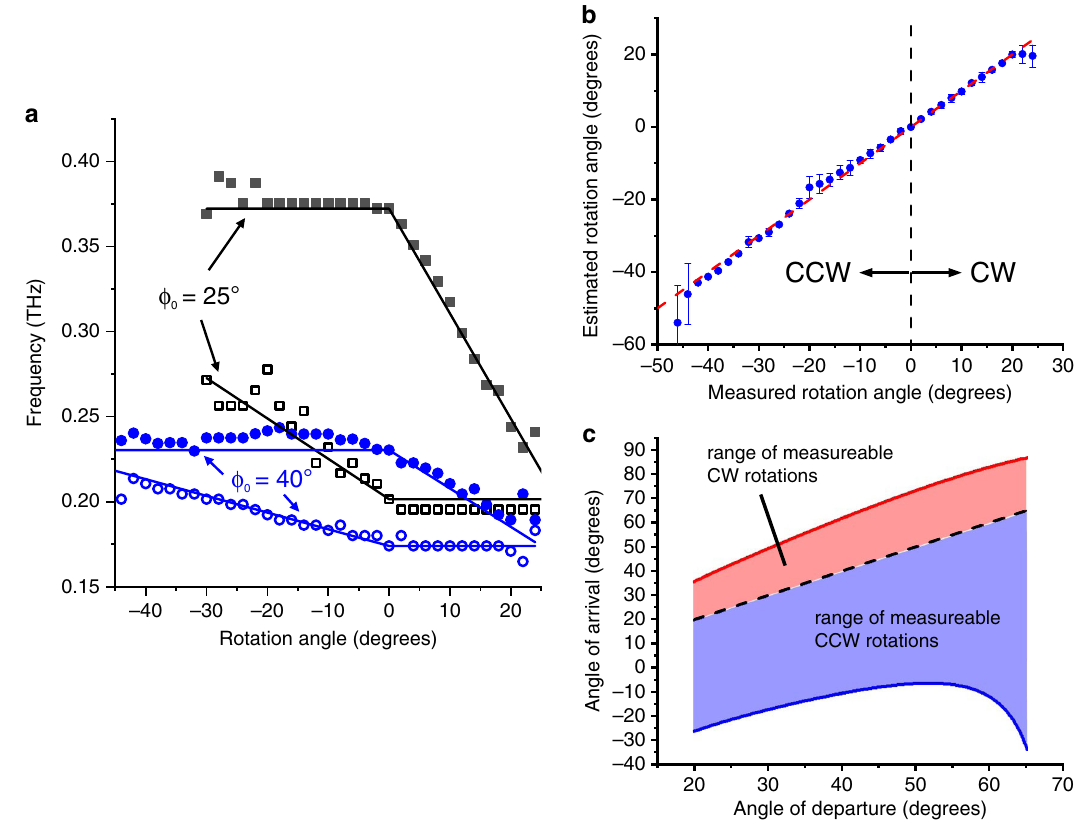
Fig. 4 Characterization of client rotation. For a given angle at which the receiver (client) is located ϕ 0 , we extract an estimate of the client ’ s rotation angle θ f f f f rot , from the high-frequency ( max ) and low-frequency ( min ) edges of the measured spectra. a The extracted values of max and min as a function of client rotation angle, for two different values of ϕ 0 . The solid lines represent the predicted values based on ray optics (Eq. 4). These results indicate the typical level of agreement between measurement and prediction, over the range of values of θ rot where a nonzero spectral width is predicted by the theory. b By compiling all measurements at a given rotation angle (at each ϕ 0 ), we extract the measurement uncertainty in the rotation angle as a function of the degree of rotation. The data points represent the average values of the extracted rotation angles at many values of ϕ 0 ; the error bars indicate the standard deviations of these averages. The uncertainty increases somewhat for larger rotations, since a smaller signal is measured for larger rotations. Nevertheless, over the range of accessible rotation angles, an average estimation error of less than 2° is obtained. c From the ray optics theory, we can predict the maximum values of θ rot which can be sensed for any given client location ϕ 0 . This is not symmetric with respect to the direction of rotation (CW vs. CCW), because of the asymmetry of the emission con fi guration (i.e., 0 < ϕ 0 < 90°). However, as noted in the text, a second transmitter, positioned on the opposite end of the LWG, would produce a symmetric emission pattern at angles 90° < ϕ 0 < 180°, which would symmetrize the rotation sensing. Source data are provided as a Source Data fi